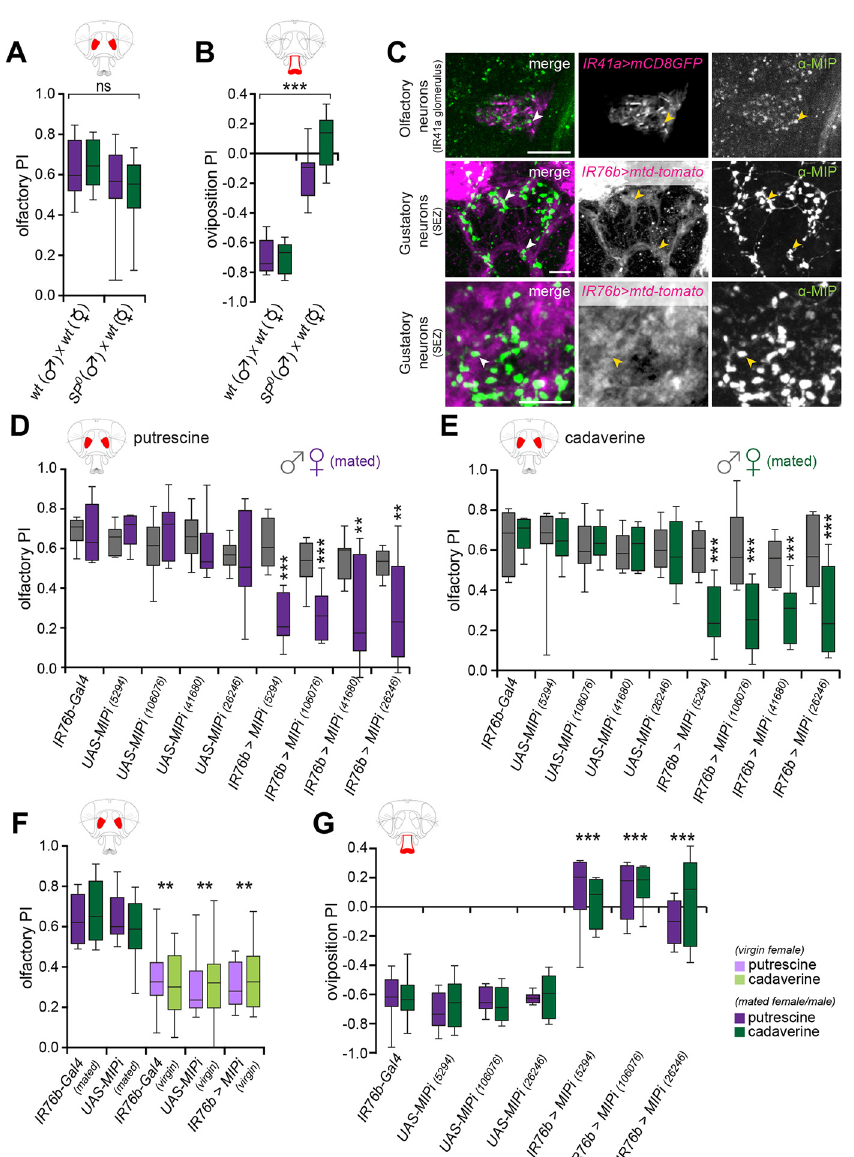
Fig 5. Myoinhibitory peptides regulate polyamine sensitivity in the context of mating. (A) Loss of sex peptide (SP) in the sperm of the male does not significantly affect chemosensory attraction of mated females to 10 ppm of polyamines. Wild-type (wt) Canton S females mated to wild-type or sex peptide mutant ( SP 0 ) males do not show a significantly altered level of attraction to the odor of putrescine or cadaverine. ( n = 8, 60 flies/trial). (B) SP 0 male-mated Canton S females lay their low numbers of eggs on either site of the oviposition assay and show no preference behavior. ( n = 8, 60 flies/trial). (C) Myoinhibitory peptide (MIP) expression in the AL and SEZ regions in the female brain. In the AL, the glomerulus innervated by IR41a OSNs is displayed ( IR41a-Gal4;UAS-mCD8GFP ). Note that MIP staining is detected in close proximity to IR41a axon terminals. In the SEZ, anti-MIP staining (green) localizes close to IR76b neuron axons and axon terminals (magenta) consistent with MIPs being secreted by IR76b neurons ( IR76b-QF;QUAS-mtd-tomato ) (see arrowheads). (D,E) MIPs modulate olfactory attraction to polyamines selectively in mated females but not males. RNAi-mediated knockdown of MIPs with four different RNAi transgenic lines in IR76b neurons ( IR76b-Gal4;UAS-MIPi ) selectively reduces the olfactory preference of mated females but not of males to 10 ppm of putrescine (D) or 10 ppm of cadaverine (E) ( n = 8, 60 flies/trial). (F) The effect of MIP knockdown ( IR76b-Gal4;UAS-MIPi ) depends on the mating state of the female, as the low attraction of virgin females to 10 ppm polyamine odor was not further reduced in virgin females with MIP knockdown compared to virgin controls without RNAi against MIPs. Box plots show median and upper/lower quartiles ( n = 8, 60